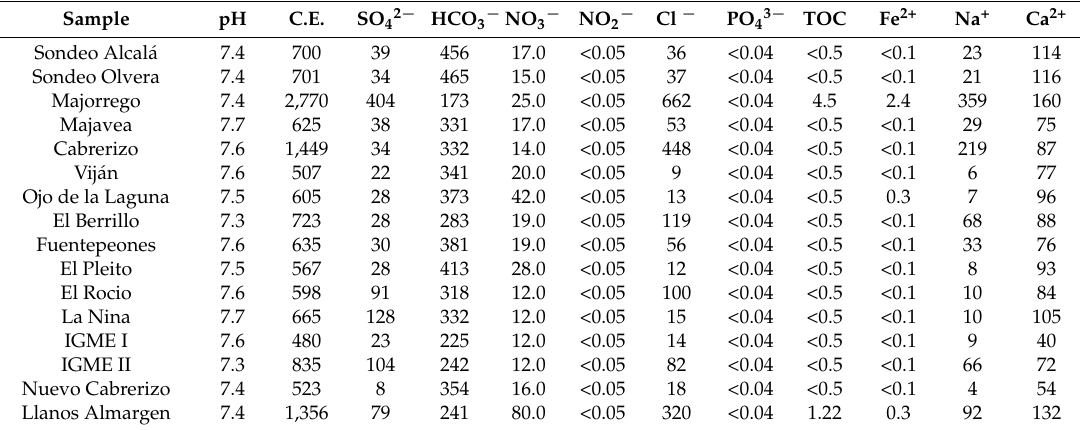
Table 2. Maximum concentrations for selected physico-chemical parameters.